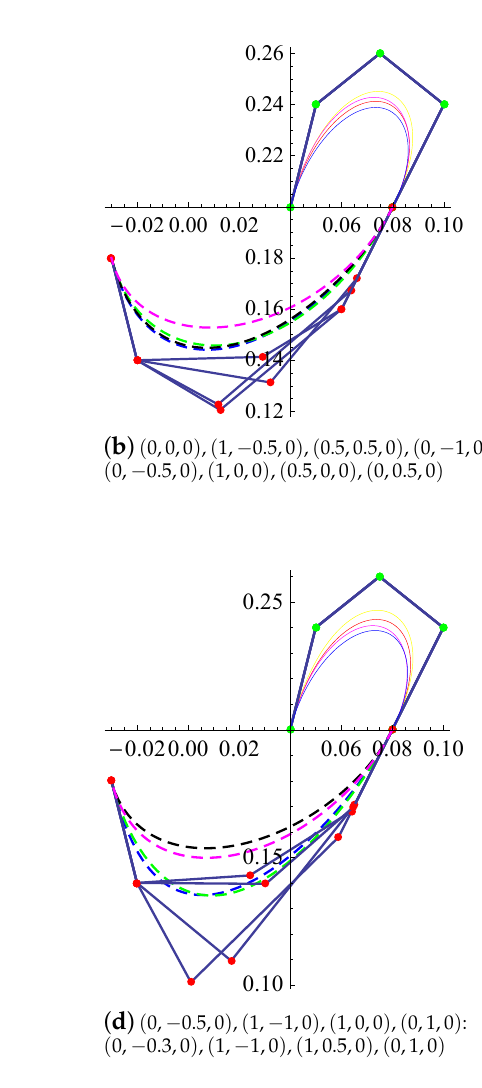
Figure 5. Graphical representation of the C 2 continuity of the GHT-Bézier curve. ( a ) ( 0,0,0 ) , ( 0,0,0 ) , ( 0,0,0 ) , ( 0,0,0 ) : ( 0, 0.5,0 ) , ( 1,0,0 ) , ( 0.5,0.5,0 ) , ( 0, − ( 0, 1,0 ) : ( 0, 0.5,0 ) , ( 1,0,0 ) , ( 0.5,0,0 ) , ( 0,0.5,0 ) ; ( c ) ( 0, − − ( 0,0,0 ) , ( 0,0,0 ) , ( 0,0,0 ) , ( 0, 1,0 ) ; ( d ) ( 0, − ( 1, 1,0 ) , ( 1,0.5,0 ) , ( 0,1,0 ) −